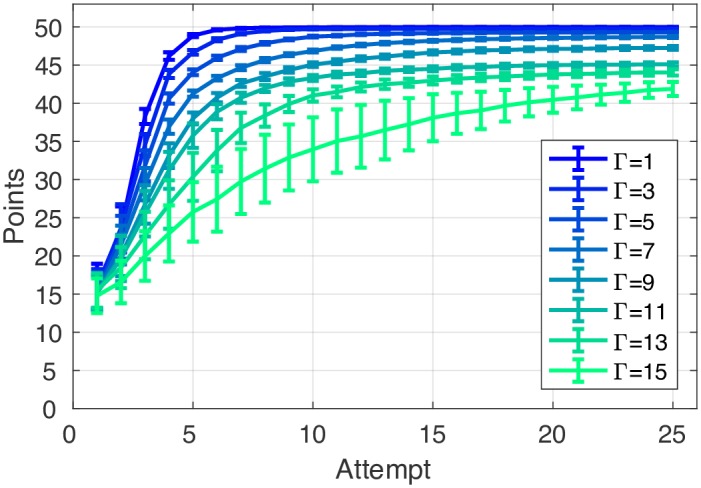
The effects of likelihood uncertainty parameter (Γ) on the speed at which the target is found.The models, with a range of likelihood uncertainty values (Γ: 1-15), were given the same set of the target cells as the participants. Model predictions show that an increasing amount of likelihood uncertainty caused learning (ability to locate the hidden target and achieve 50 points) to be slower and often incomplete after 25 attempts. Error bars represent model performance variance (95% CI) across the 24 targets. The model’s performance for each target was averaged over 100 runs.